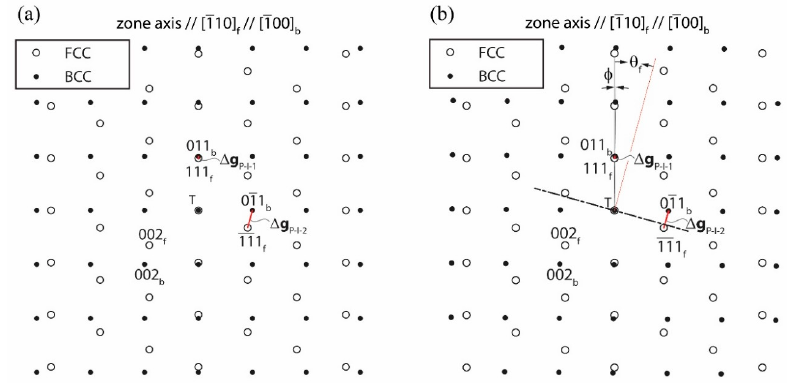
Figure 4. The 2D O-line approach to determine the OR and IO between FCC Cu and BCC Cr. ( a ) the composite diffraction patterns at ideal N-W OR. Two principal Δ g vectors are NOT parallel to each other; and ( b ) the composite diffraction patterns after the BCC lattice is rotated by ϕ about the common zone axes. Two principal Δ g vectors are parallel to each other and define the average interface orientation (dashed-dotted lines).